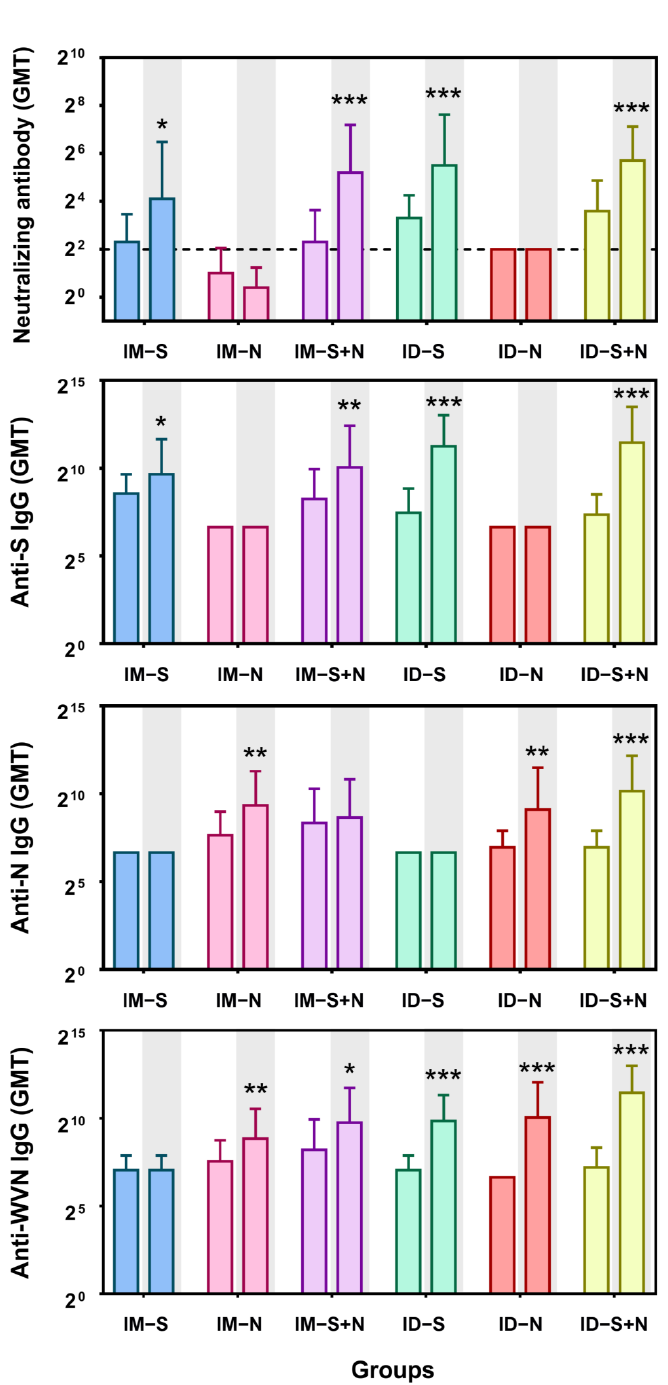
Figure 2. Levels of antibody production induced by experimental recombinant proteins after ID and IM immunization. The titers of neutralizing antibodies and IgG antibodies against S, N, and whole virus antigens (WVN) were detected 14 days after the primary and booster immunizations. The white background is 14 days after the first immunization (primary), and the gray background is 14 days after the second immunization (booster). IM-S: immunized with the S protein via the IM route; IM-N: immunized with the N protein via the IM route; IM-S + N: immunized with the S/N mixed protein via the IM route; ID-S: immunized with the S protein via the ID route; ID-N: immunized with the N protein via the ID route; ID-S + N: immunized with the S/N mixed protein via the ID route. The dotted line in the neutralizing antibody graph represents the positive threshold (neutralizing antibody titer of 4). The differences between the immunized groups and the control group were analyzed by t -test. *, p < 0.05; **, p < 0.01; ***, p < 0.001 compared with the control group ( n = 10 per